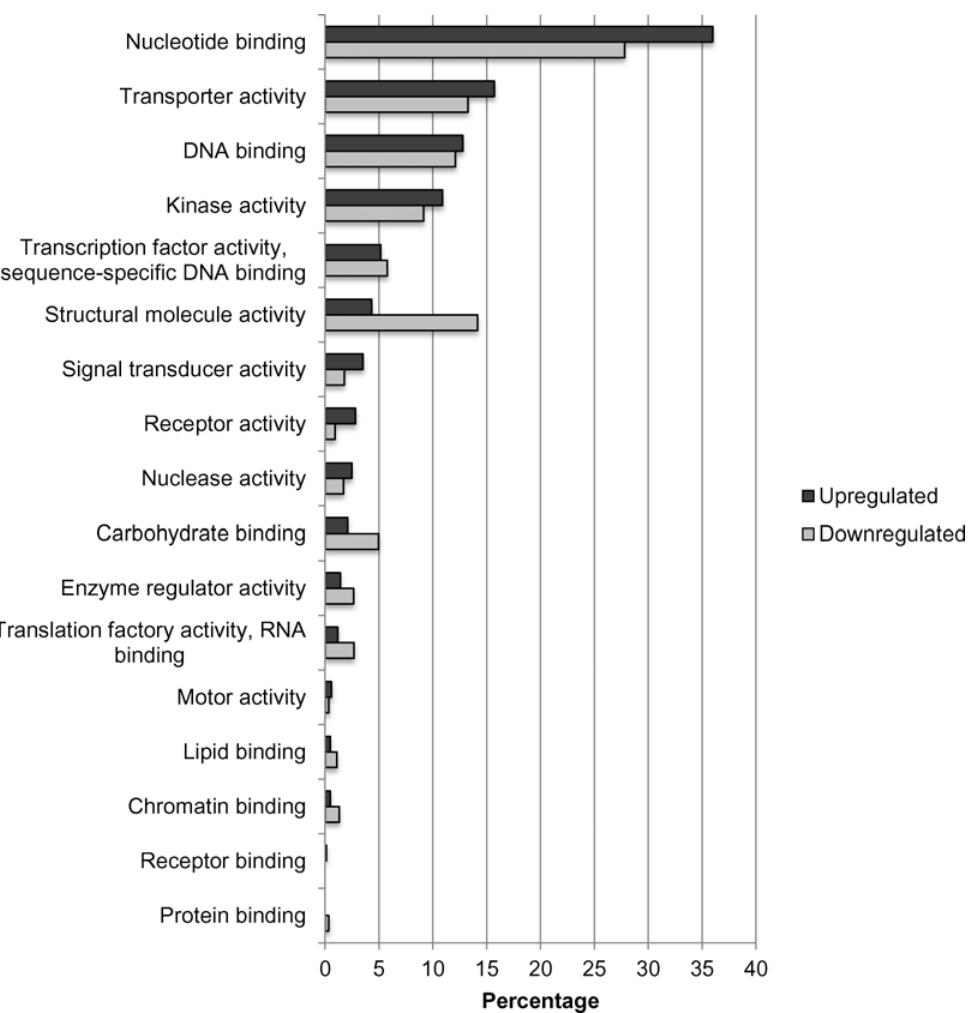
Fig 12. Percentage of upregulated (total number = 853) and downregulated (total number = 1,751) transcripts when nickel resistant Betula papyrifera genotypes were compared to nickel susceptible genotypes. Transcripts were assigned gene ontology and grouped by molecular function using